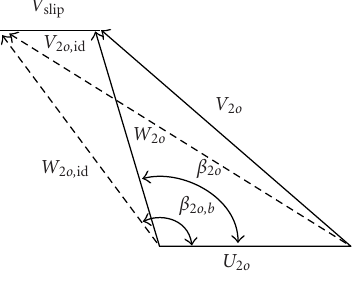
Figure 3: Modified velocity triangle with slip velocity at the im- peller